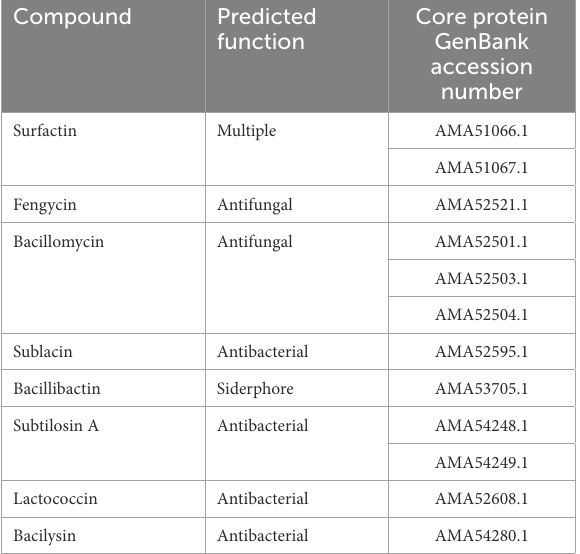
C. acnes (Table 6 and Supplementary Figure S2). Results from this study demonstrated a broad antimicrobial profile of DE111 ® ,